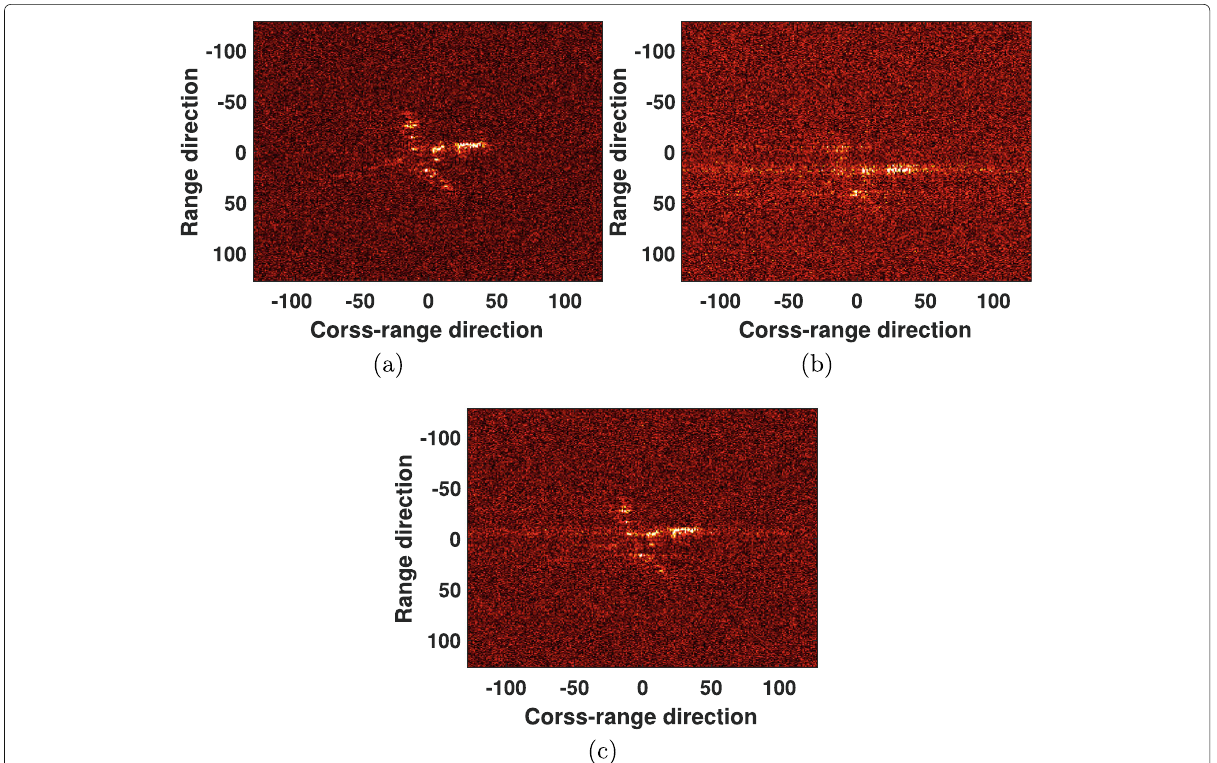
Fig. 13 Imaging results under a − 25 dB SNR. a The imaging result of the proposed algorithm, b the imaging result of the ACM, and c the imaging result of the